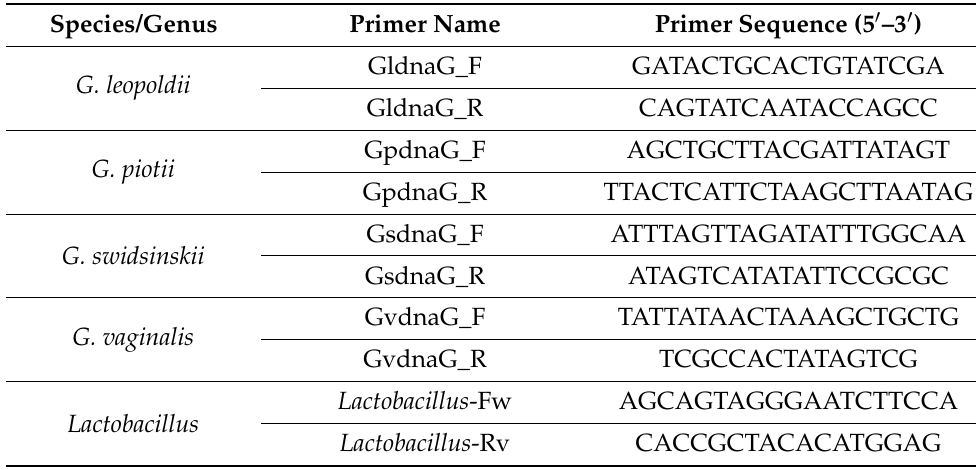
Table 2. Primers used for